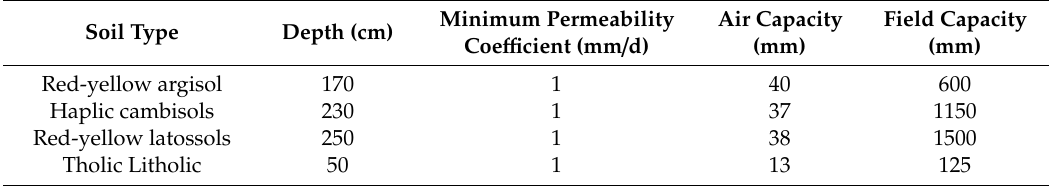
Table 3. Soil parameters used in the hydrologic model. The air capacity and field capacity (water holding capacity) are practical measures to describe the pore size di ff erences between water that can be held against gravity (middle pore storage) and water that cannot (macro pore storage),